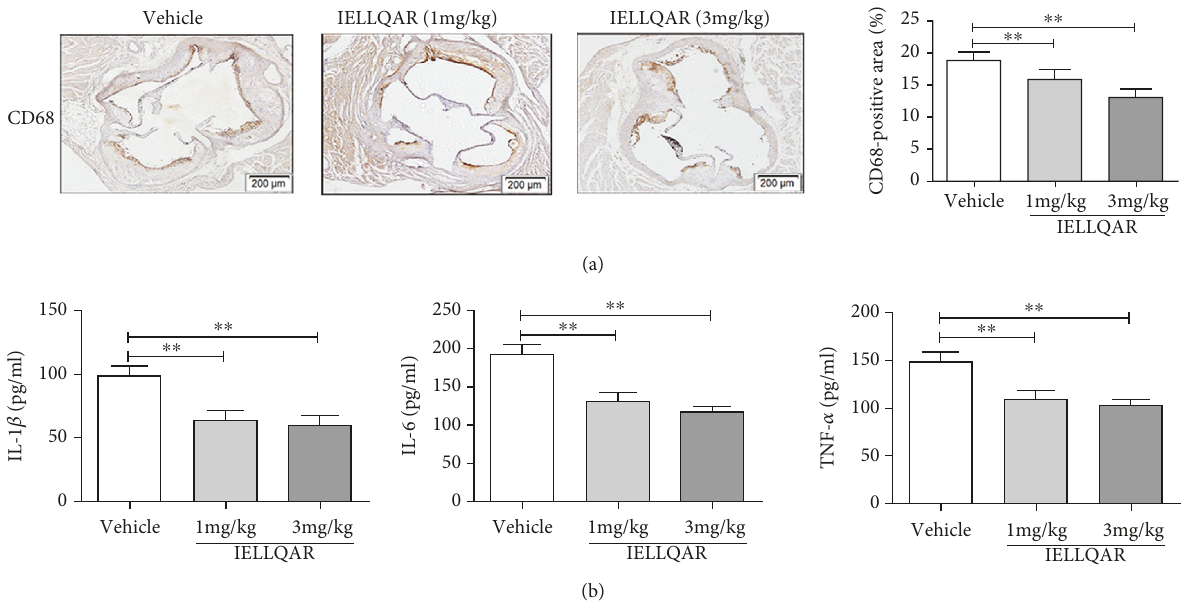
Figure 4: IELLQAR decreases monocyte in fi ltration and serum proin fl ammatory cytokine levels in WTD-induced mice. Mice were treated as described in Figure 3. (a) Representative images of immunohistochemical staining of lesions in the aortic sinus with CD68 ( n ≥ 5 ). Scale bar: 200 μ m. (b) Serum IL-1 β , IL-6, and TNF- α levels were measured by ELISA ( n ≥ 5 ). Data are presented as the mean ± SEM ; ∗ p < 0 05 , ∗∗ p < 0 01 , and ∗∗∗ p < 0 001